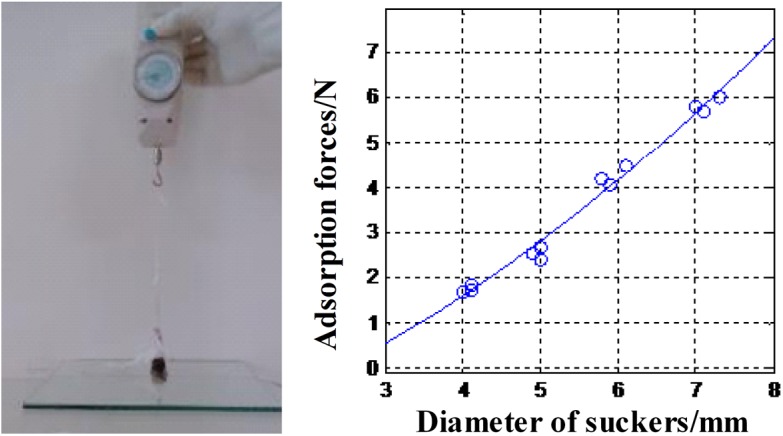
The adsorption forces of different suckers (Data in S1 Dataset).